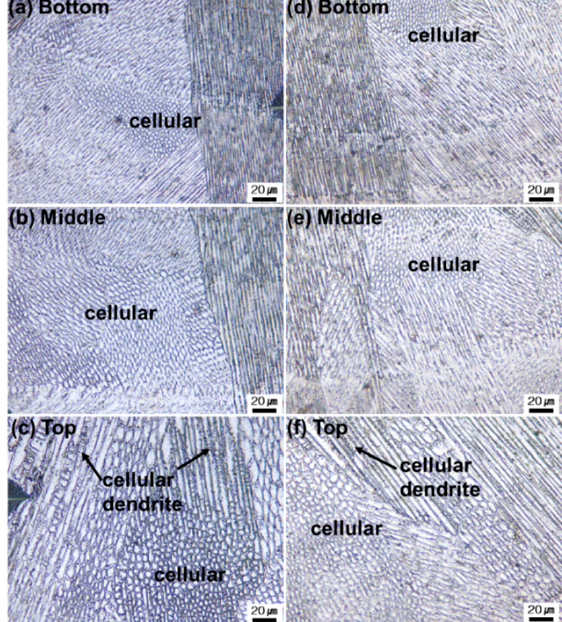
Figure 6. Optical microscope image of microstructure at each position of the deposit: (a–c) microstructure at the bottom, middle, and top of the deposit for 0-s interlayer time; (d–f) microstructure at the different bottom, middle, and top of the deposit for 0-s interlayer time.